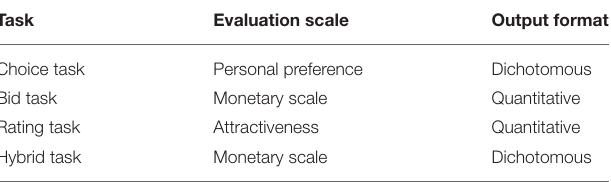
TABLE 1 | Summary of different tasks in evaluation scale and output